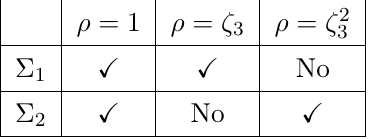
is contained in Σ i ρ